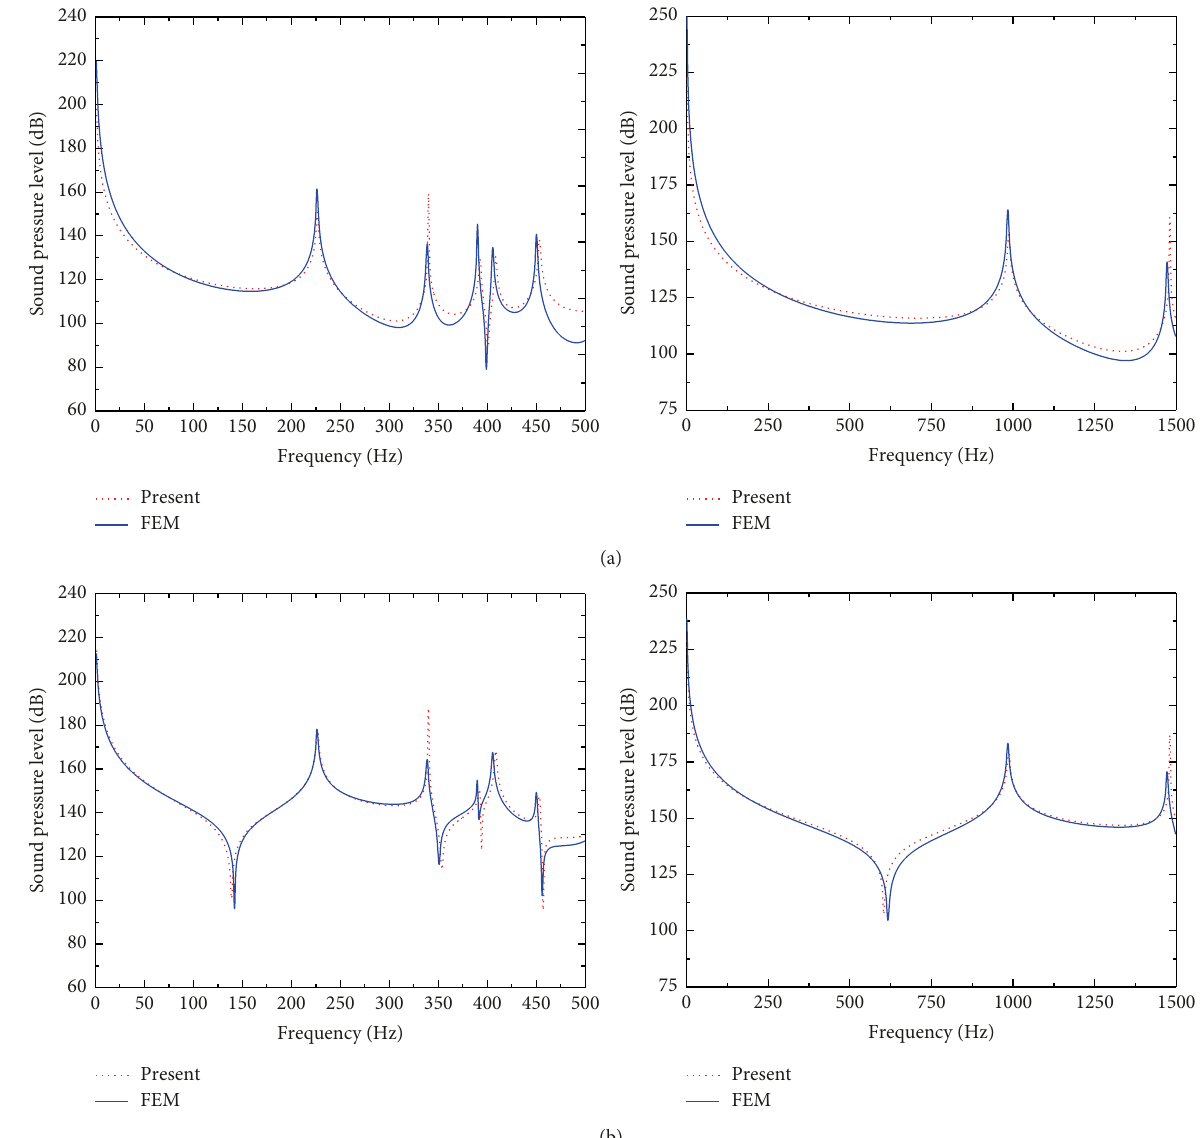
Figure 9: Acoustic pressure response of the triangular prism acoustic cavity with rigid walls under the unit point sound source excitation. (a) Observation point 1. (b) Observation point